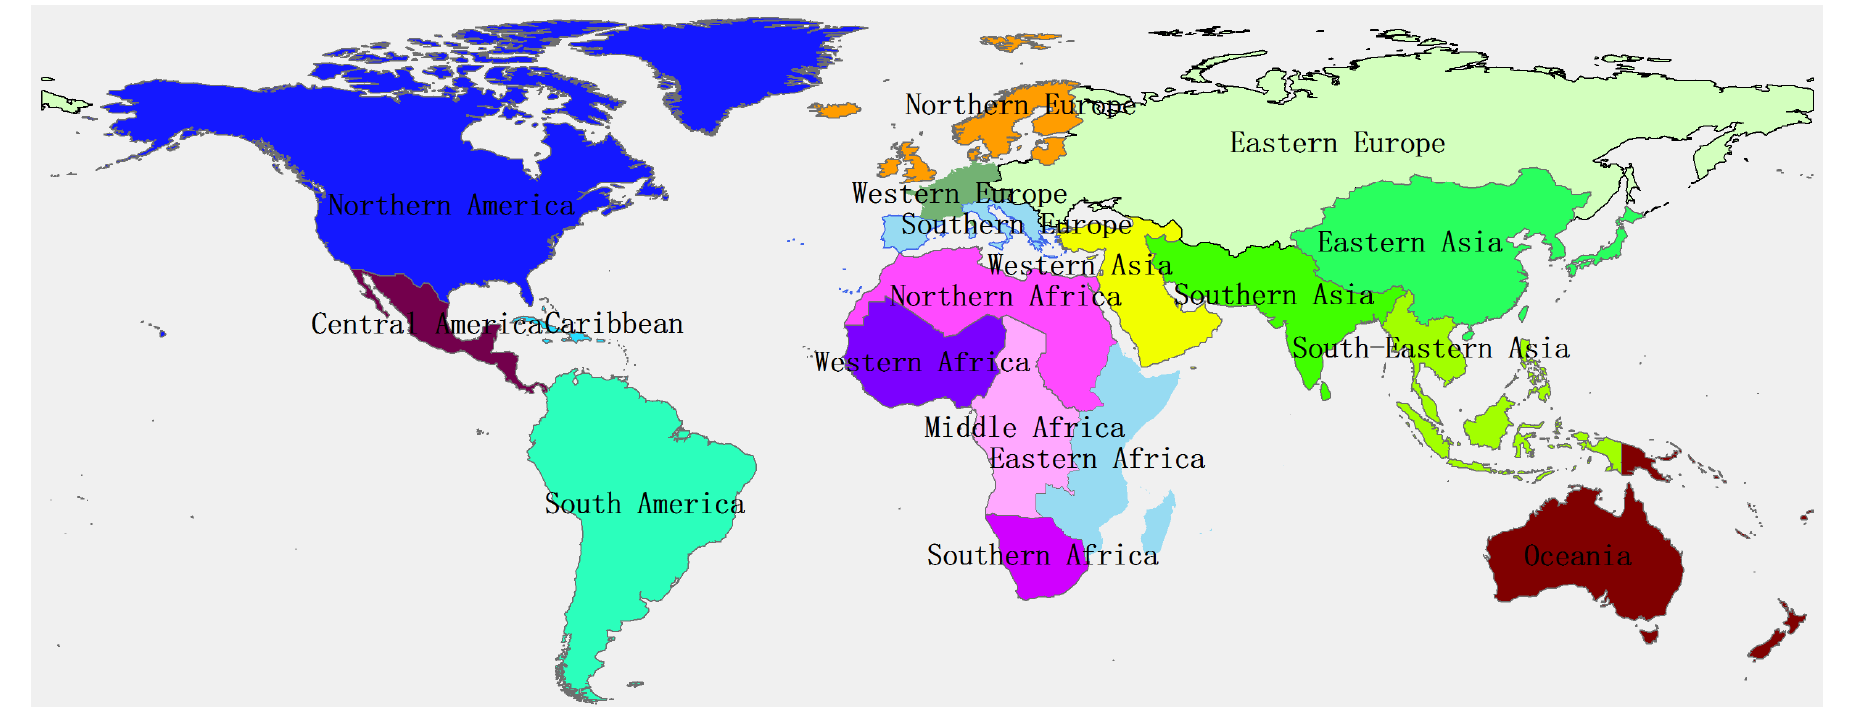
Figure 1. The world regions used in this